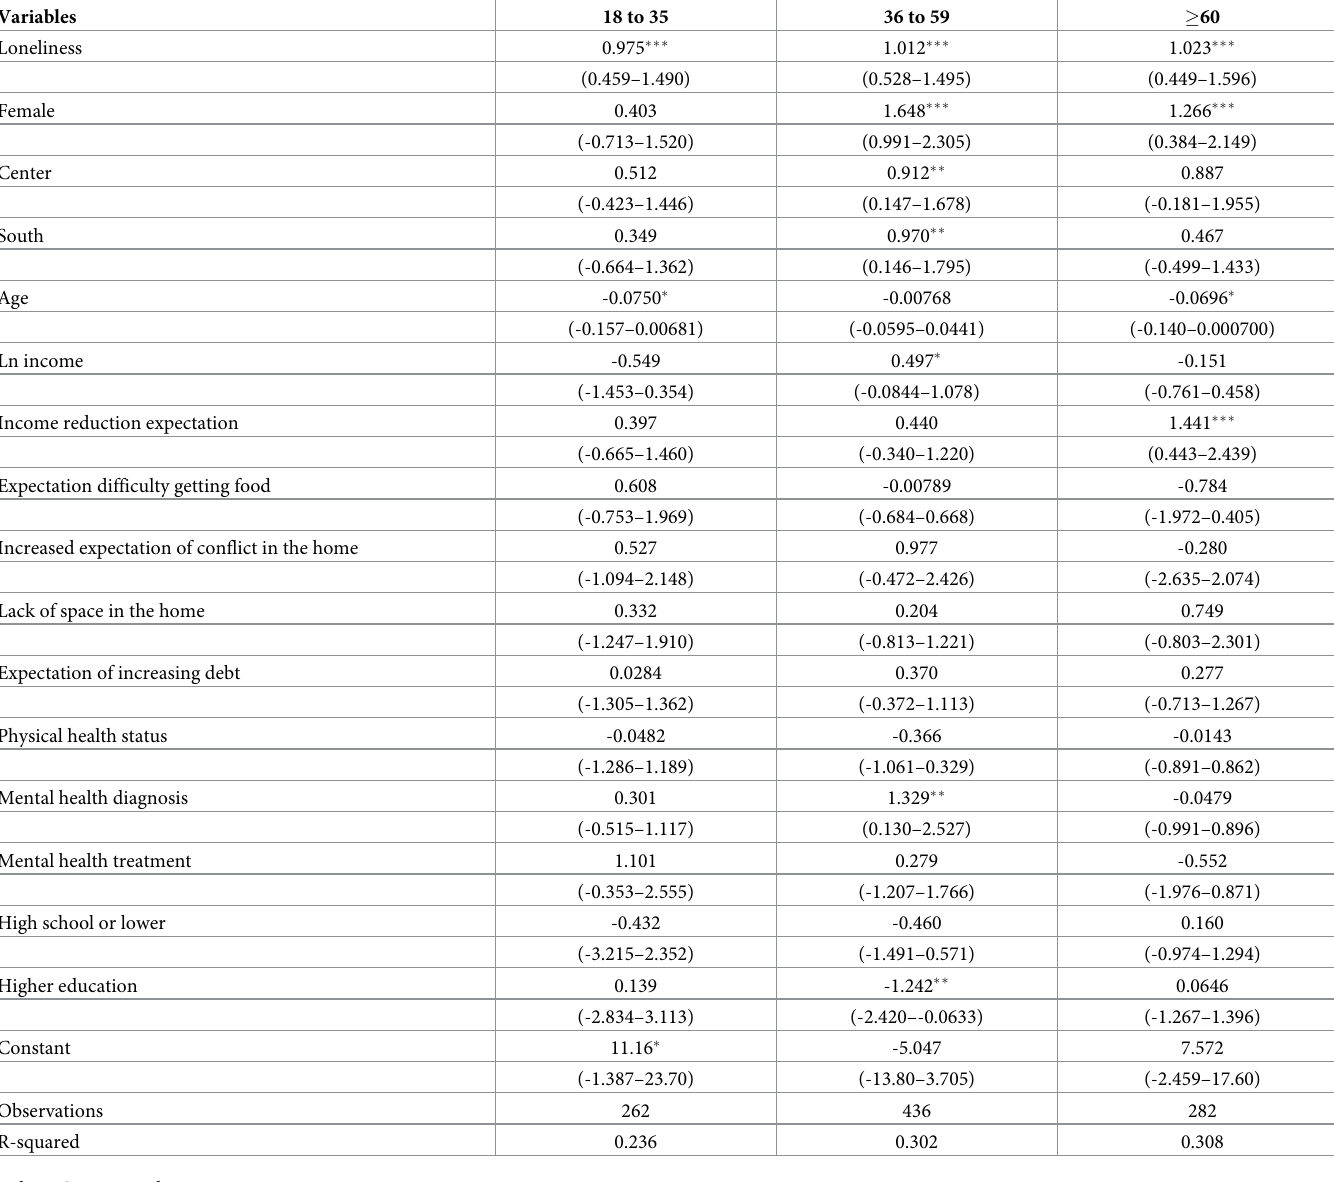
Table 5. Regression models of psychological distress by age